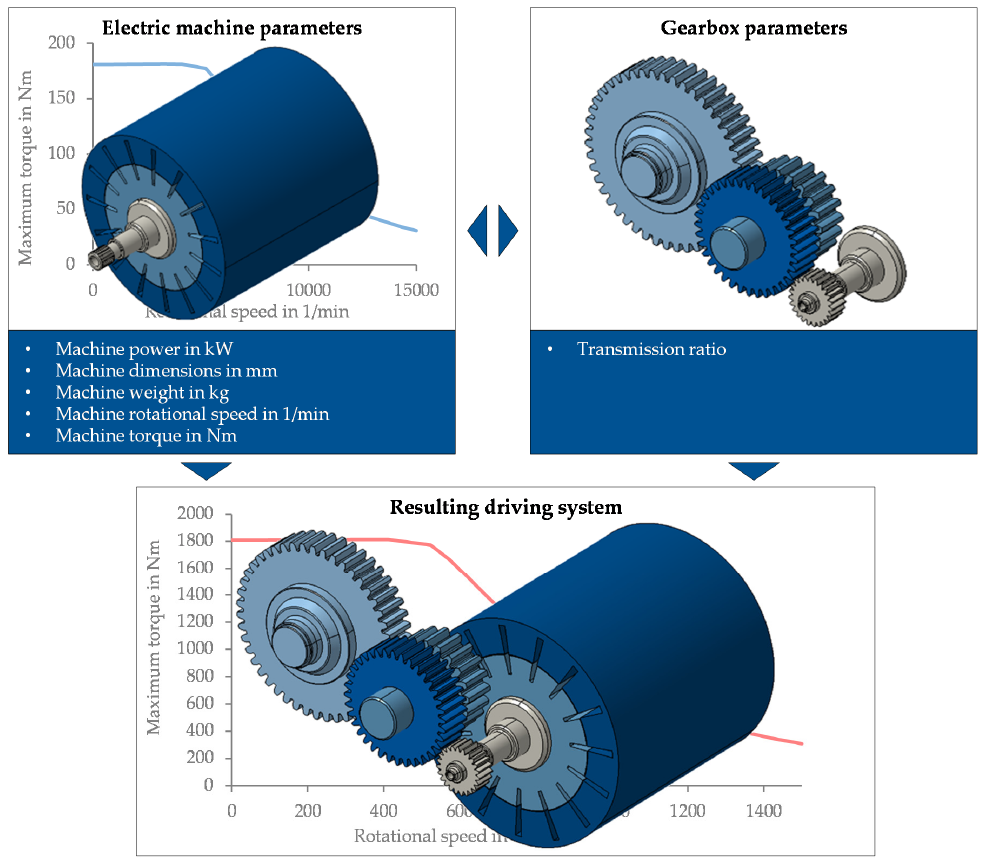
Figure 6. Overview of the design parameters for the electric machine and gearbox.